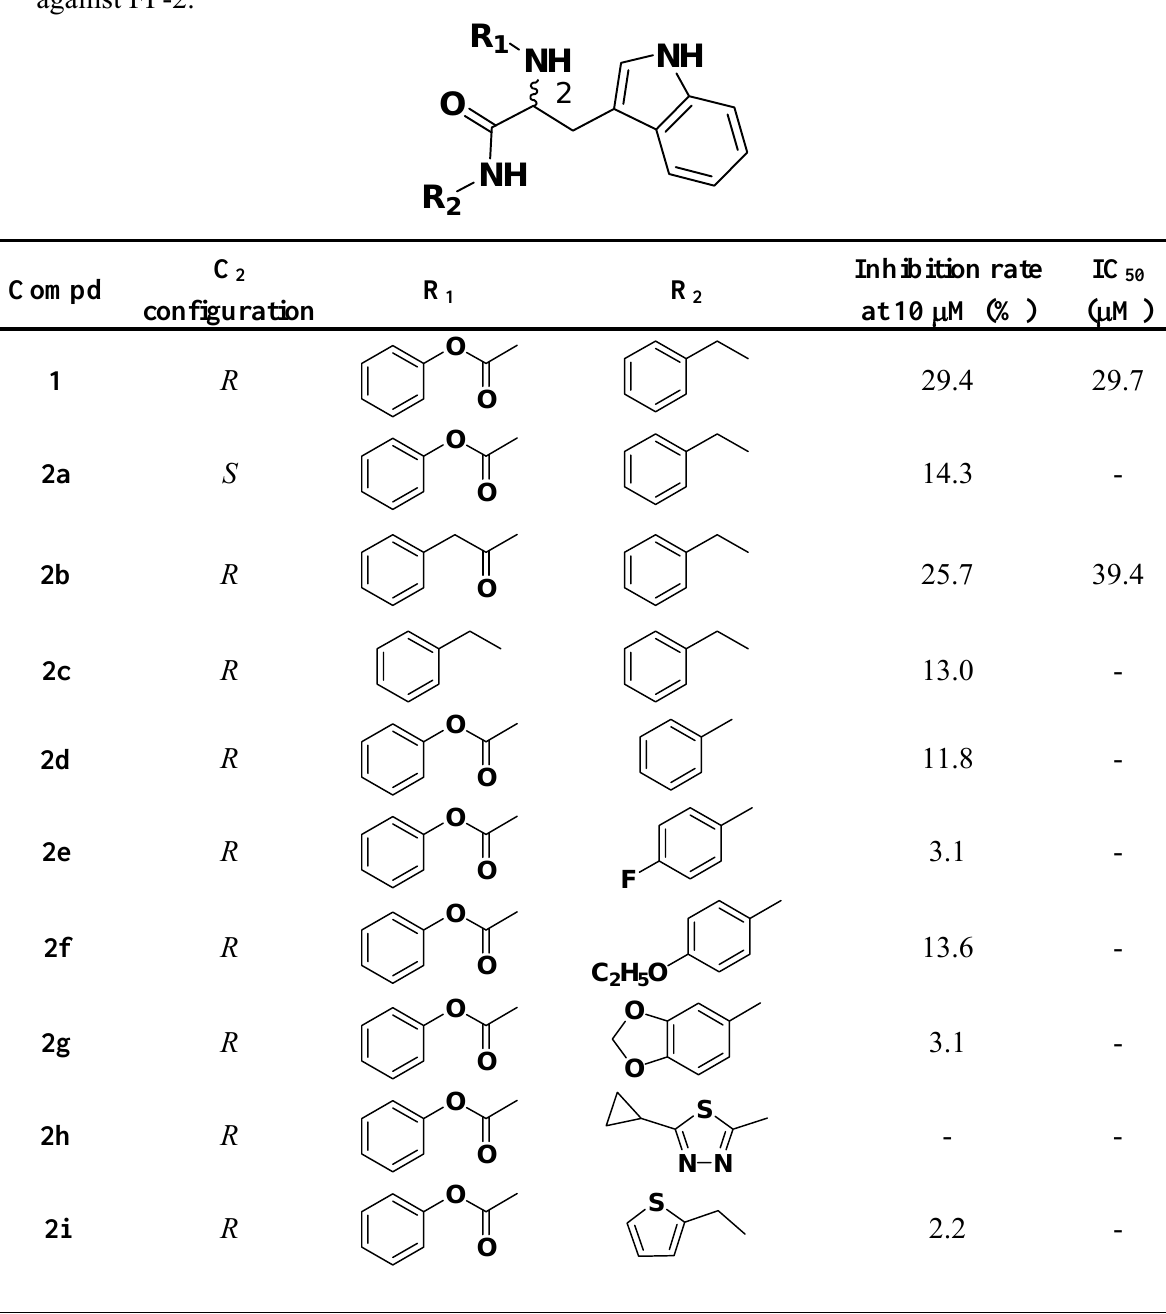
Table 1. Chemical Structures of Compounds 1 and 2a - m and Their Inhibitory Activities against